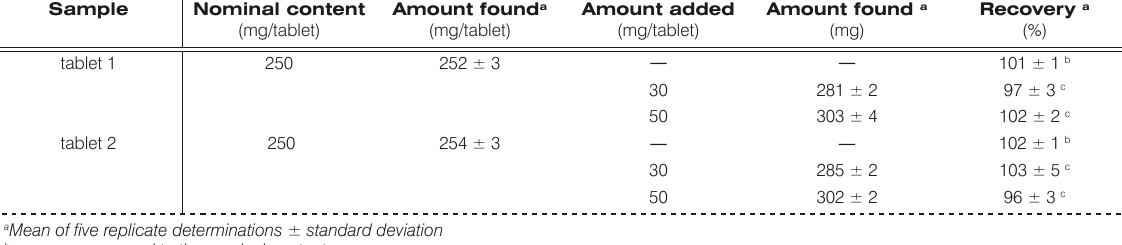
Table 2. Determination of PVK in pharmaceutical formulations